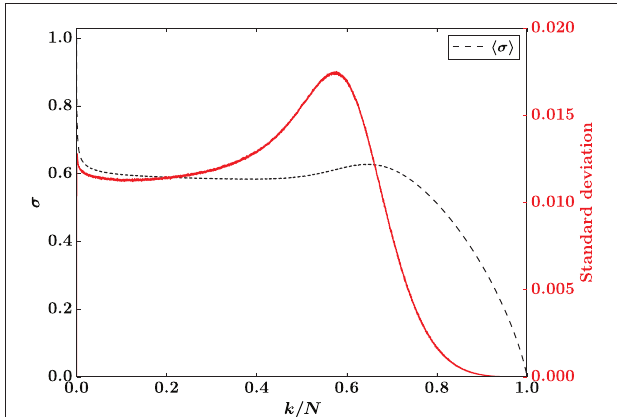
FIGURE 2 | Sample averaged load curve for the LLS model (black, left axis) and corresponding standard deviation (red, right axis) for a Weibull threshold distribution with β = t 0 = 1. Results are from simulations on a square lattice ( N = 128 2 ) with 1.5 × 10 5